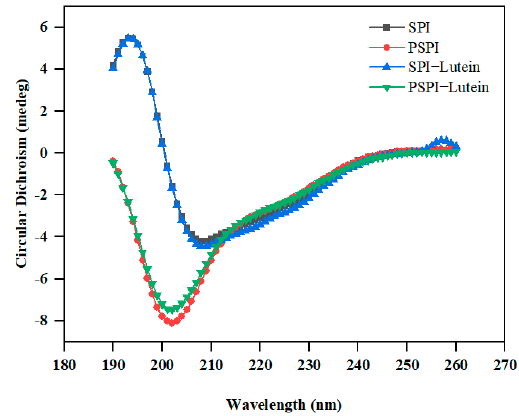
Figure 5. CD spectra of SPI and PSPI (0.1 mg/mL) in the absence and presence of lutein (0.03 mg/mL).